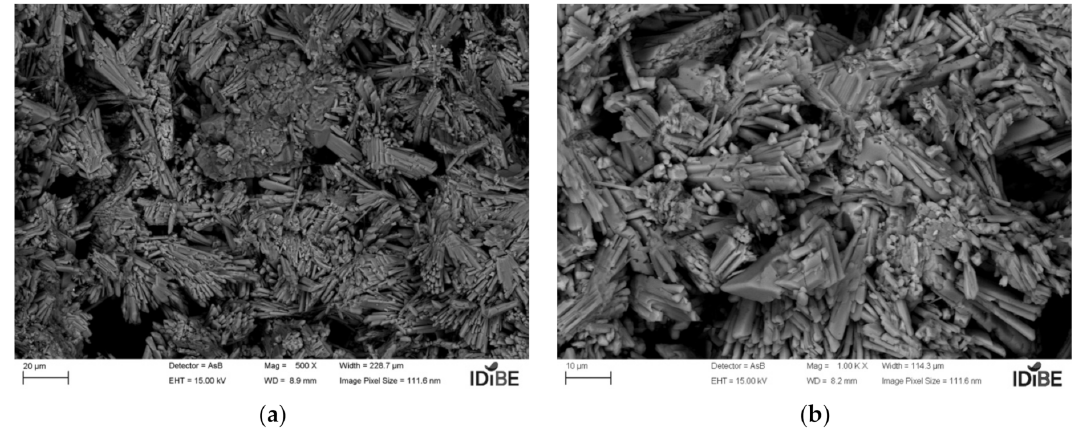
Figure 15. Micrograph of the 0.02% citric acid compound (lot I1): ( a ) 20 µ m; ( b ) 10 µ m (source: the